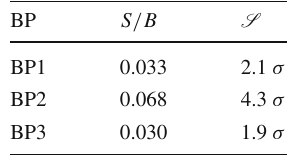
signal significance for the benchmark points at 13